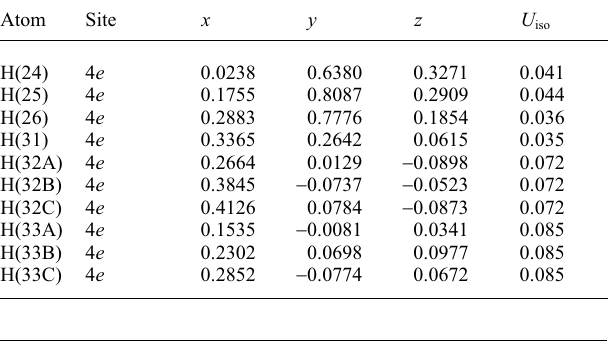
Table 2. Atomic coordinates and displacement parameters (in Å 2 )